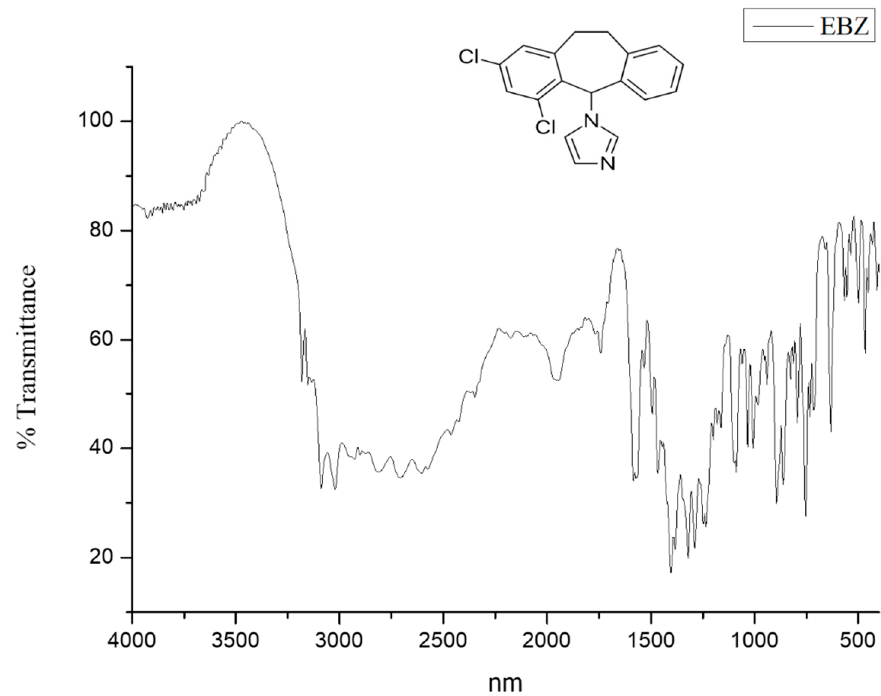
Figure 1. FTIR graph of eberconazole.